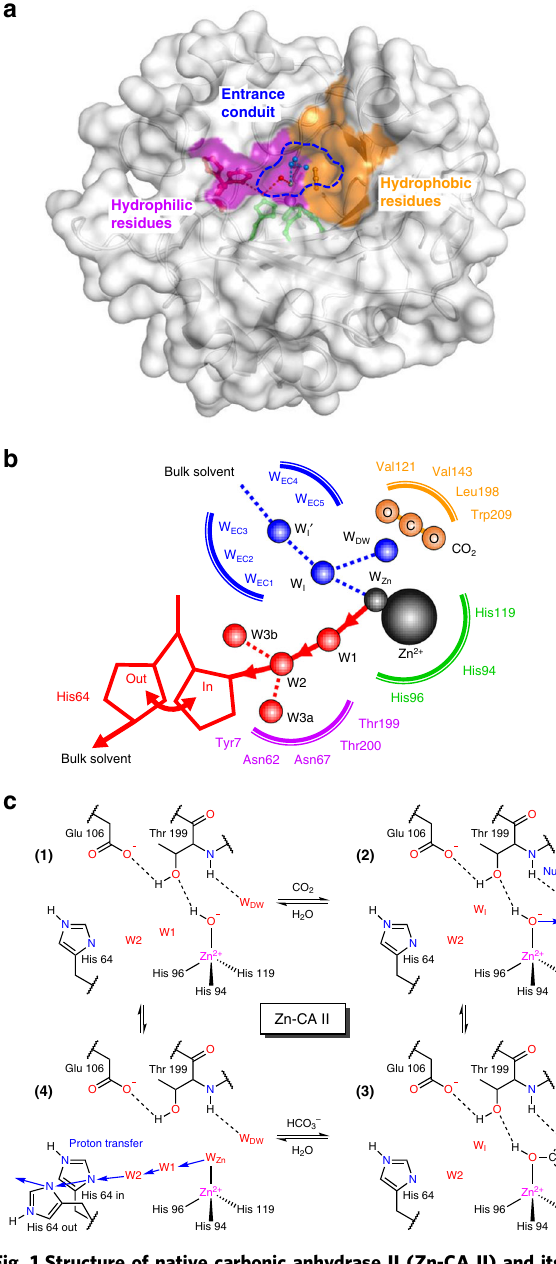
Fig. 1 Structure of native carbonic anhydrase II (Zn-CA II) and its catalytic mechanism. a The active site consists of zinc binding site, hydrophobic/hydrophilic regions, and entrance conduit (EC). b The water networks in the active site are responsible for the proton transfer (red) and substrate/product/water exchange (blue) during enzyme catalysis. c The CO 2 hydration reaction mechanism of Zn-CA II. First, CO 2 binds to the active site, leading to a nucleophilic attack by the zinc-bound hydroxyl ion onto CO 2 . HCO 3 − thus formed is subsequently displaced by the water molecule in fl owing through EC. The HCO 3 − molecule likely binds to Zn 2 + ion in a monodentate mode and its OH group is held at the Zn 2 + ion due to the hydrogen bonding with Thr199 52, 53 . This product binding con fi guration leads to a weak interaction between the product and Zn 2 + ion, thereby facilitating fast product dissociation 54 . Finally, proton transfer occurs via the network (W Zn → W1 → W2 → His64) provided by the protein